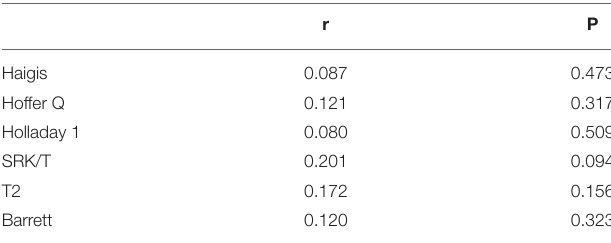
28–30 mm but less accurate in AL > 30 mm (31). Zhang found TABLE 7 | The association between absolute error and axial length using simple regression